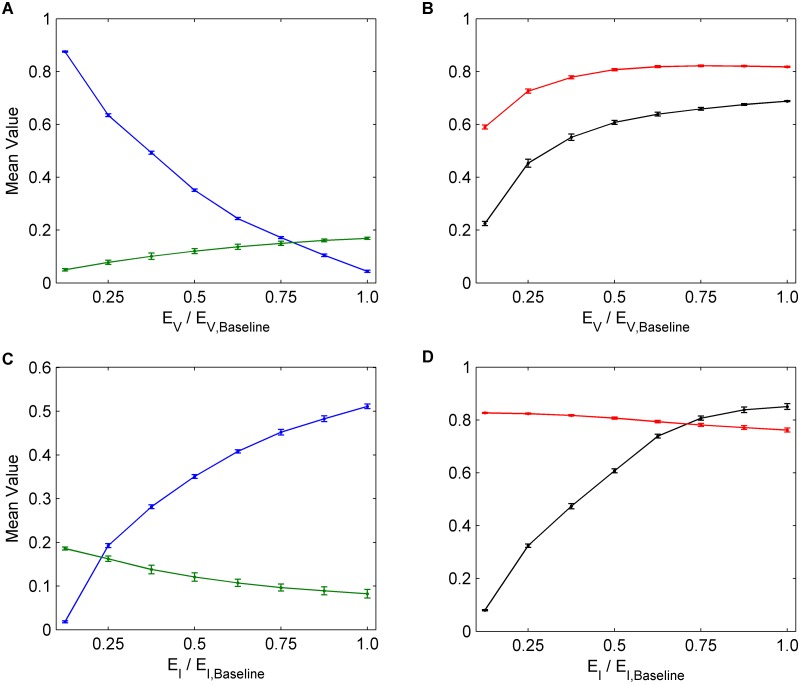
The effects of infection and vaccination costs on interventions.Univariate sensitivity analysis for E
V and E
I. The numbers on the horizontal axes correspond to multiples of the baseline values for E
V and E
I, hence 1.0 corresponds to the baseline value of the each parameter. (a), (c) Average values across 30 seasons for vaccination coverage (blue) and incidence (green). (b), (d) Average values across 30 seasons for NPI usage amongst susceptible individuals (black) and infectious individuals (red). Confidence intervals represent two standard deviations of the mean of the 100 parameter sets across 30 simulated seasons.